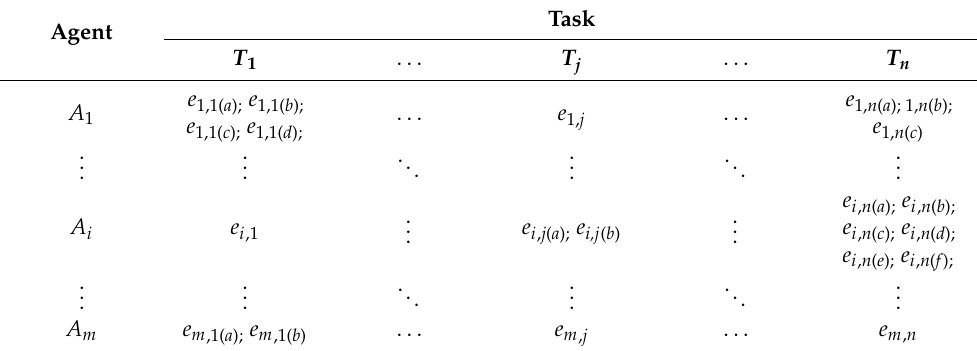
Table 2. Uncertain assignment problem with efficiency parameters.